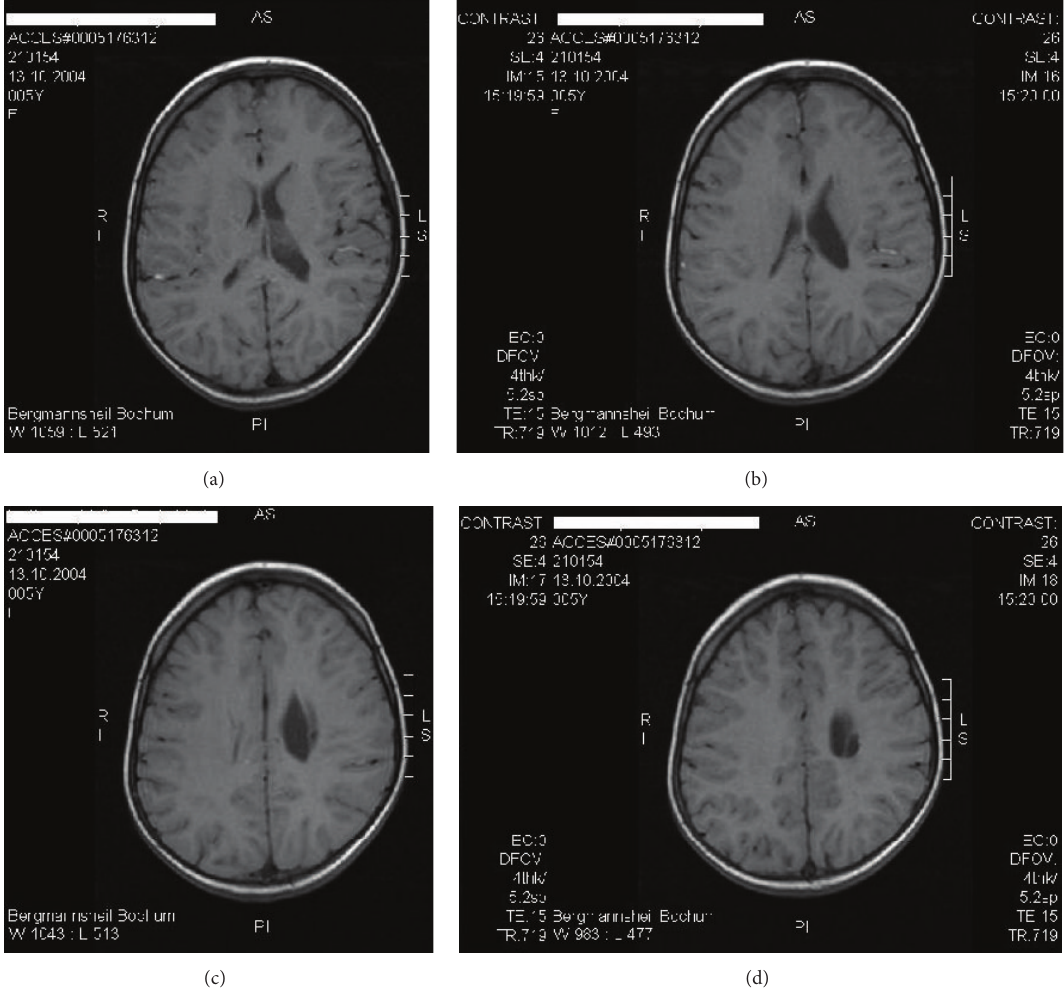
Figure 4: MRI of the brain (M.H.) at the age of 5 years (2009). Arterial ischemic stroke in the left central and paraventricular white matter with enlarged left ventricle before transplantation of autologous cord blood mononuclear cells (1.5-Tesla, head coil array, T1w TSE sequence).